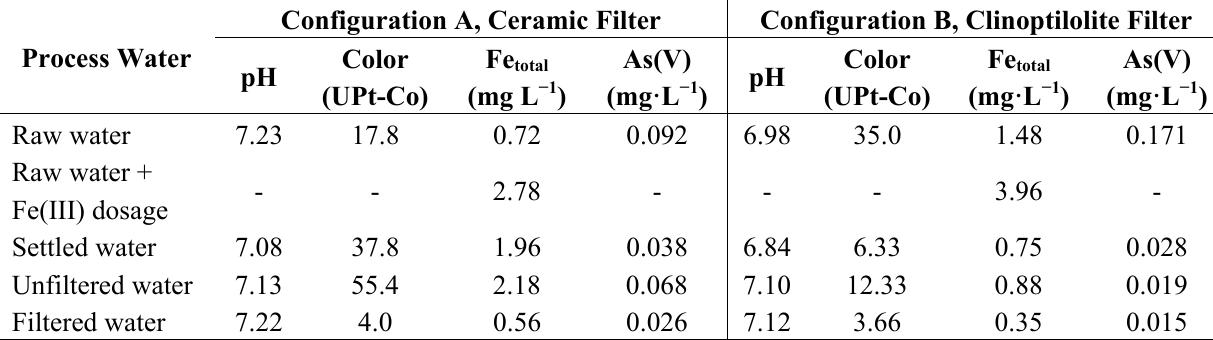
Table 6. Results of the evaluation of the NCMG